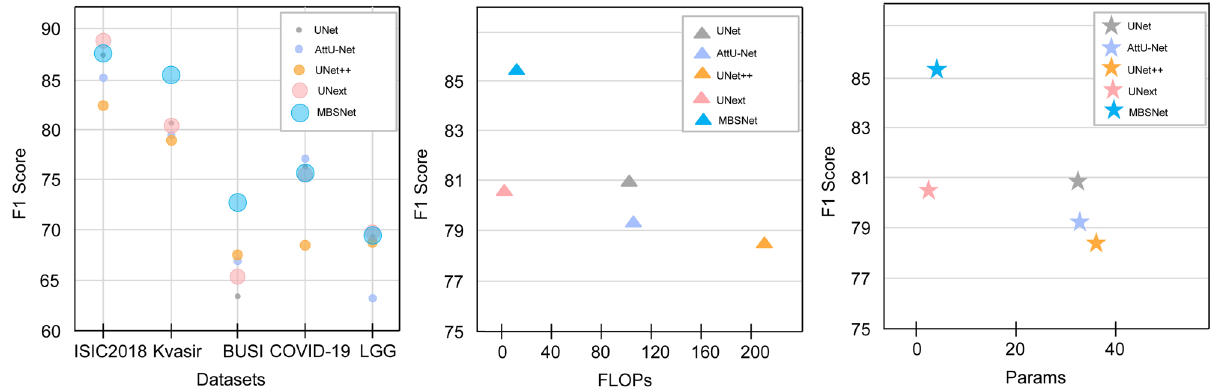
Figure 5. The first image shows the F1-Score of each network on five datasets. The Y axis of the second and third images is the F1-Score of each network on the Kvasir dataset, and the X axis corresponds to FLOPs and parameters, respectively. MBSNet is the best network in terms of overall